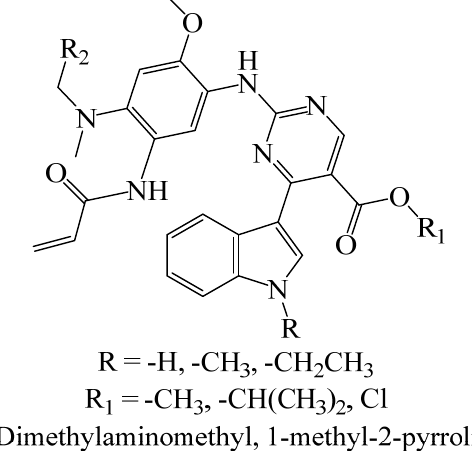
Figure 3. Possible basic pharmacophoric structure of